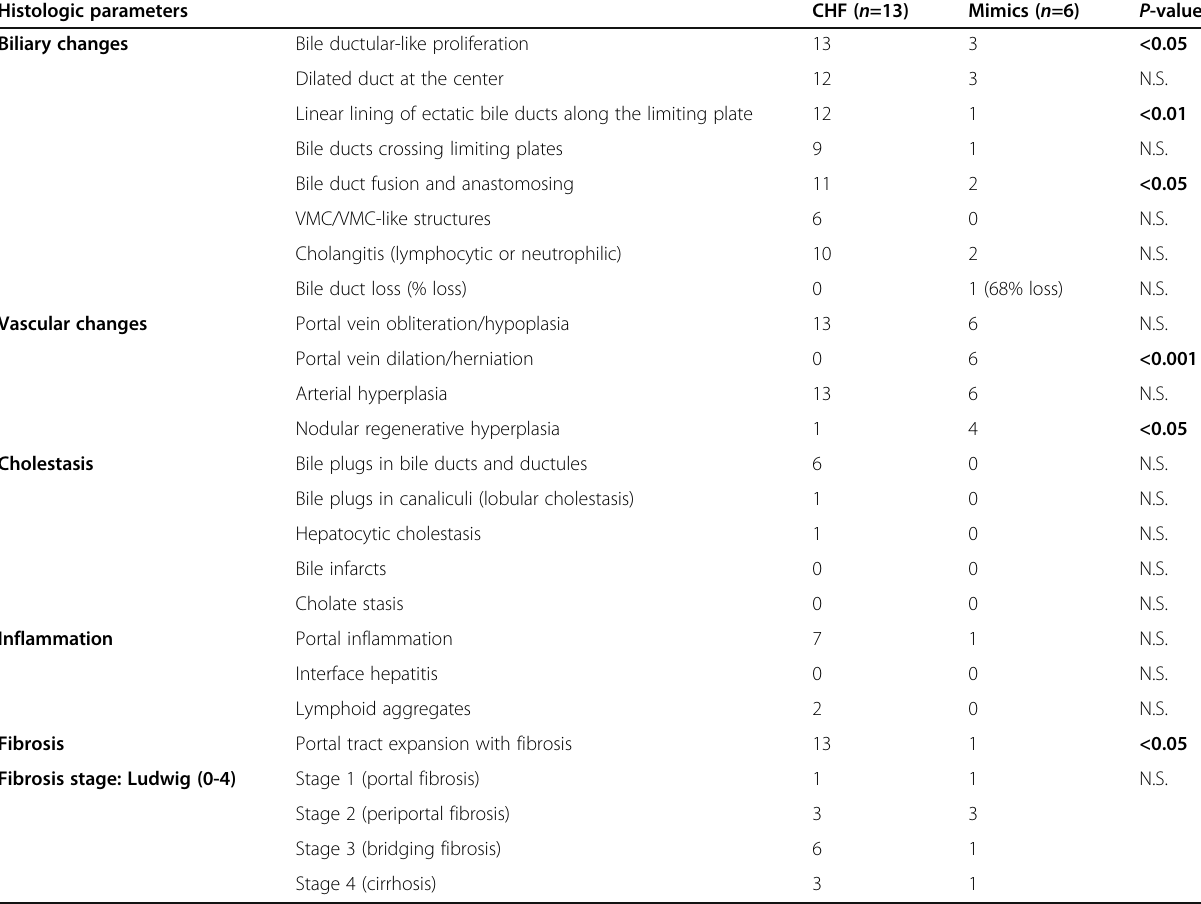
Table 2 Histologic comparison between congenital hepatic fibrosis (CHF) and its mimics Histologic